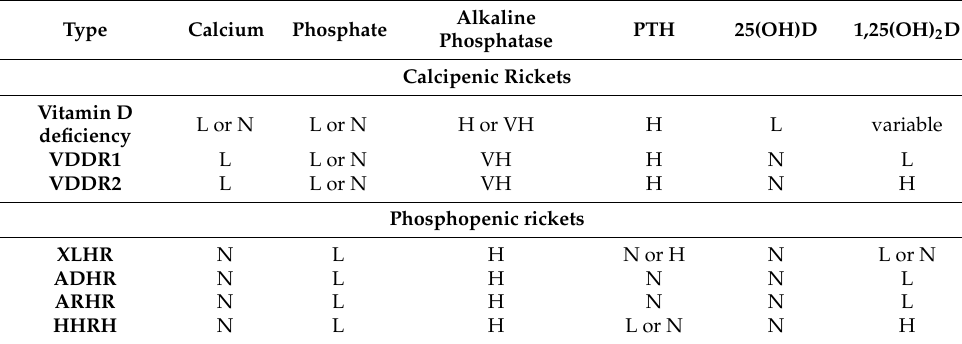
Table 1. Salient features of different types of